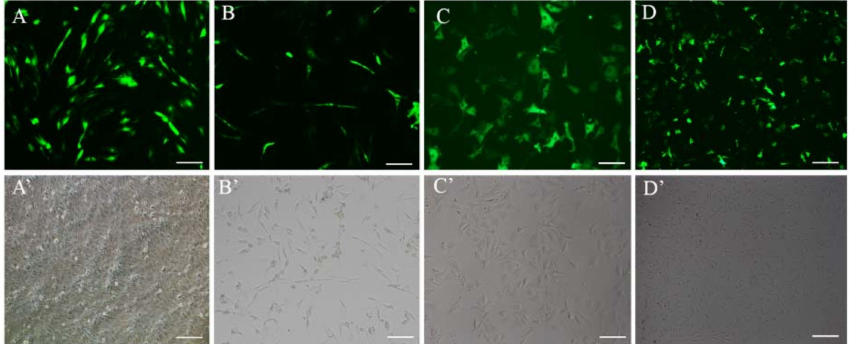
Figure 6. Long-term stability and expression experiments. ( A ) The FEC cells were transfected Po β -actin ∆ − 1080/ − 801 ∆ − 500/ − 201-eGFP on day 2; ( B ) two weeks after the G418 antibiotic was used in the transfected FEC cells and the proportion of GFP overexpression cells is significantly increased; ( C , D ) The best cell colony with GFP florescence following expending culture and almost all cells had high fluorescence emission. The GFP overexpression stable FEC cell line cultured until week 4 and month 2 in medium without G418, respectively. Bar = 100 µ